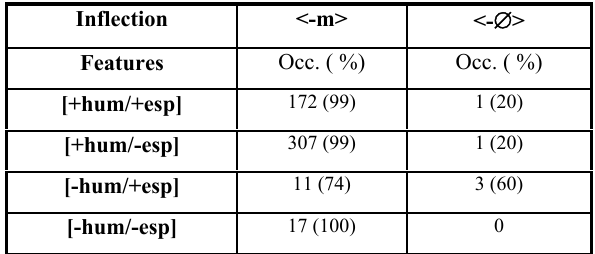
Table VI – Third person null subjects and the semantic features – EP – Oeiras Inflection